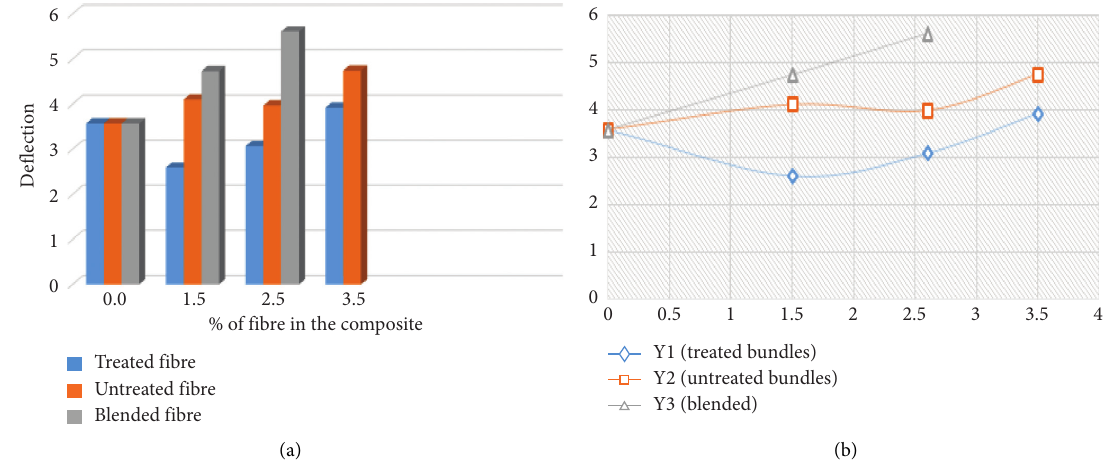
Figure 7: Deflection of the reinforced hybrid fibre/gypsum plaster composite at different wt. % fibre dosages for different